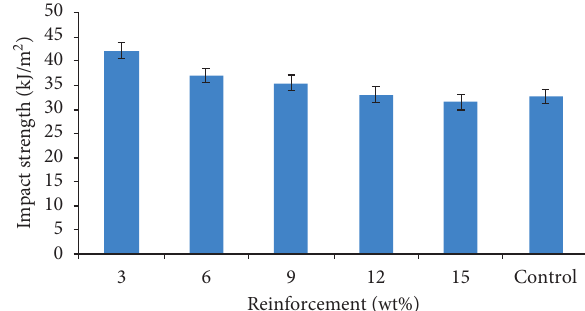
Figure 5: Variation in impact strength of the developed composites and the control.